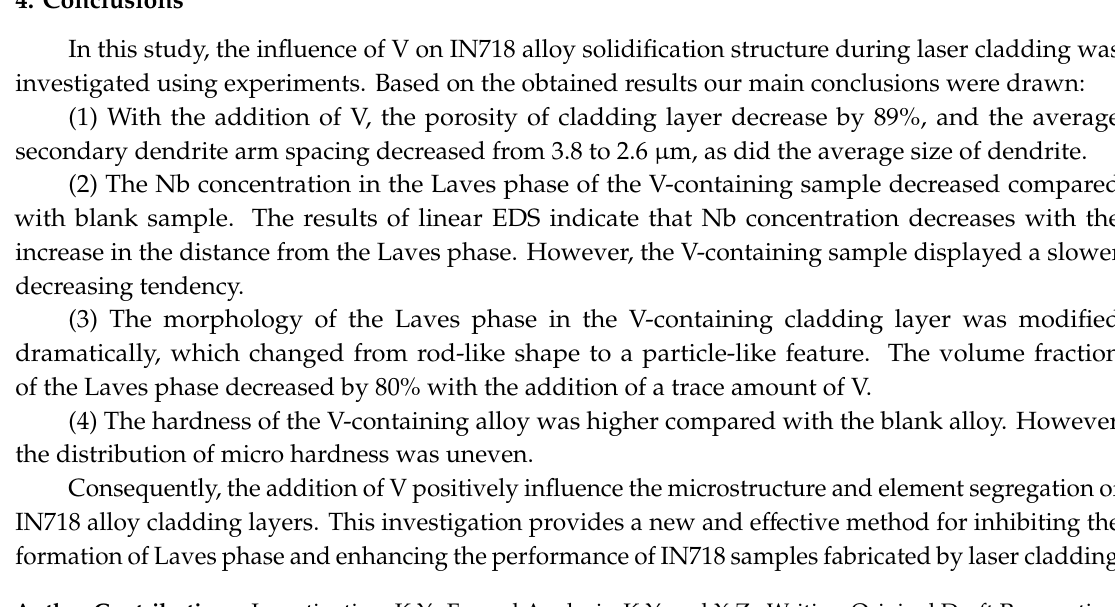
Figure 13. Vickers hardness testing. ( a ) Typical indentation surface morphologies of two alloys; ( b ) comparison of Vickers hardness between No.1 and No.2 alloy.